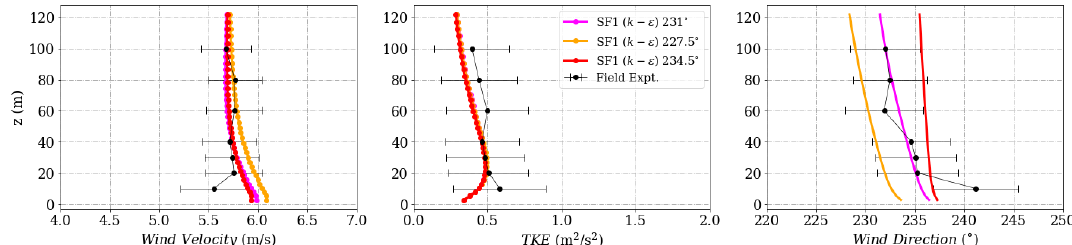
Figure 19. Simulation results and experimental data for wind velocity on the southwest ridge for Tower 20 (tse04). The locations of the masts are given in Fig. 2.